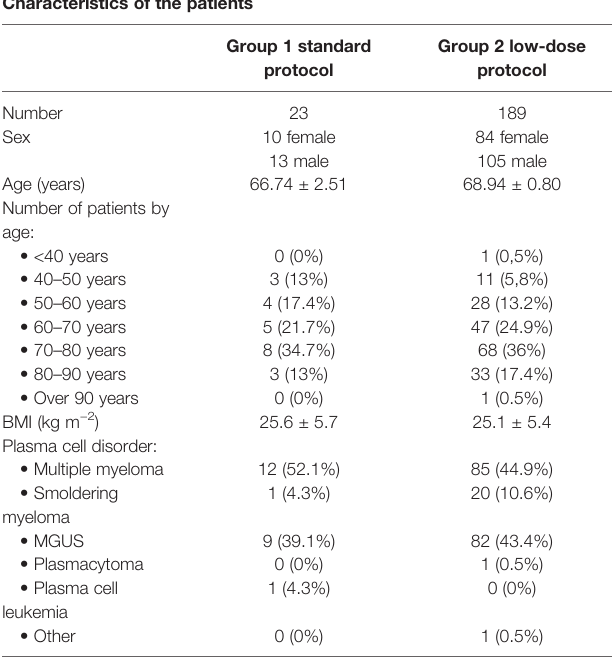
TABLE 1 | Characteristics of the patients. Characteristics of the patients